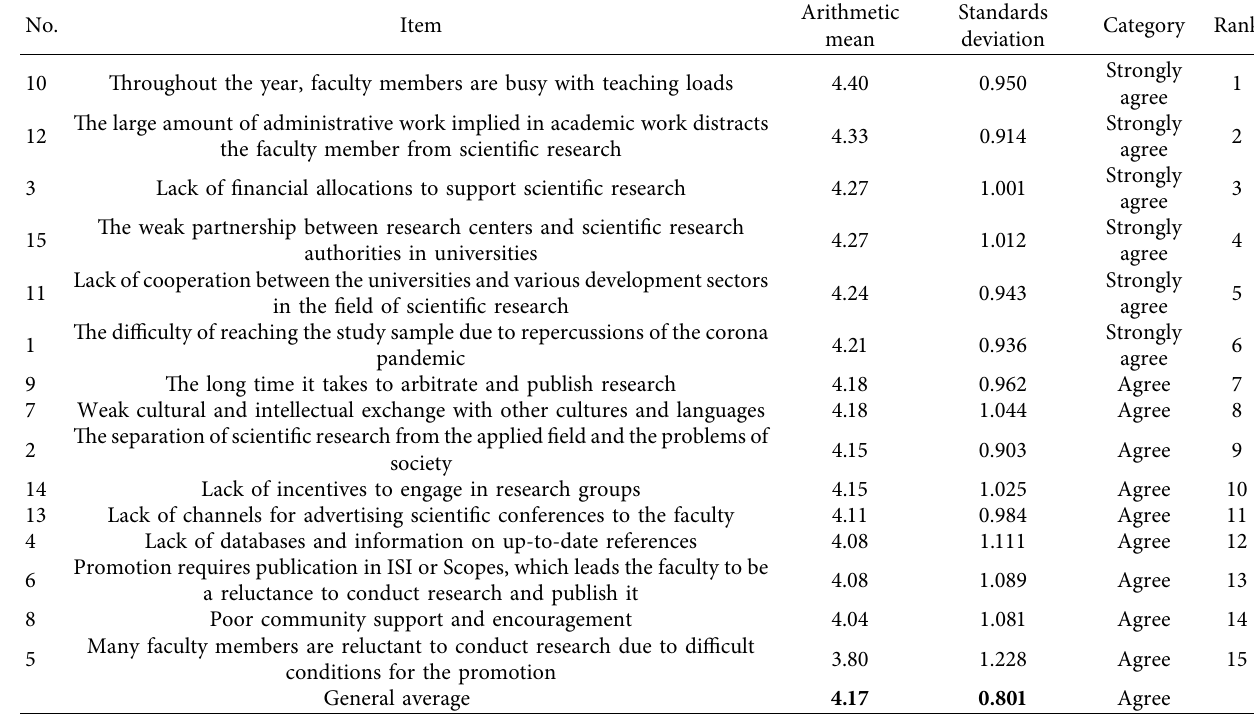
Table 7: Study participants’ responses about the challenges facing the scientific research in the area of educational sciences during corona pandemic in Saudi universities in descending order as per the approval averages.